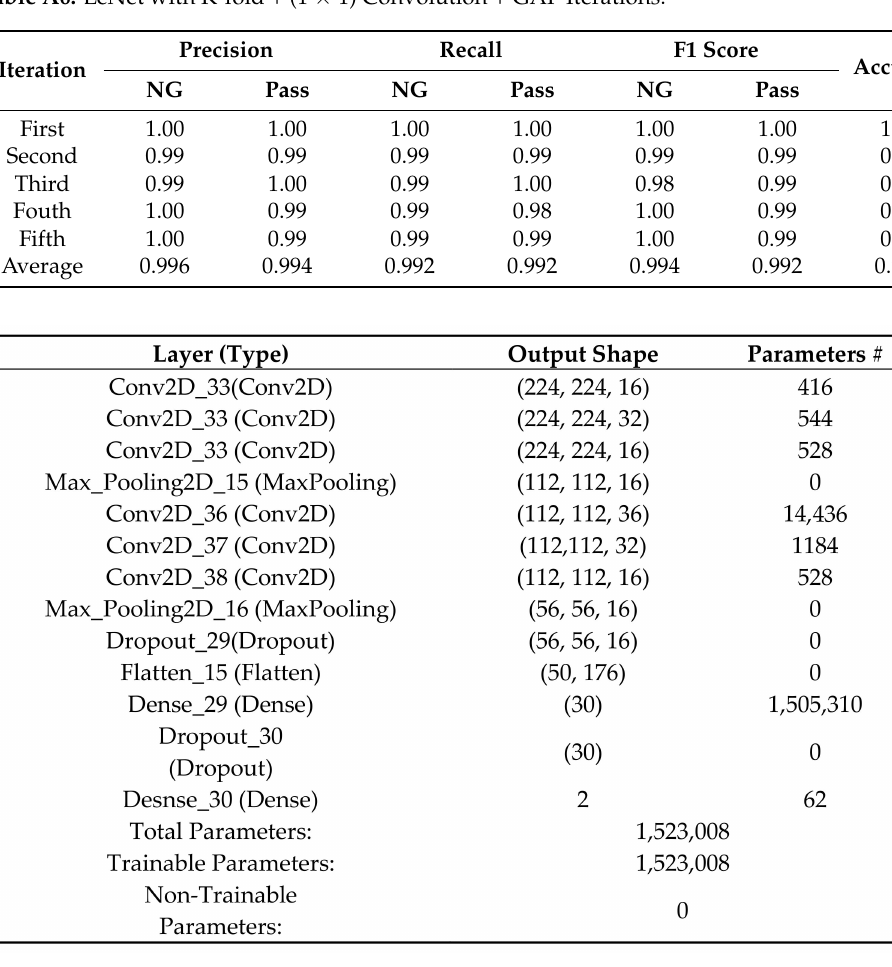
Figure A4. LeNet + (1 × 1) Convolution Layers